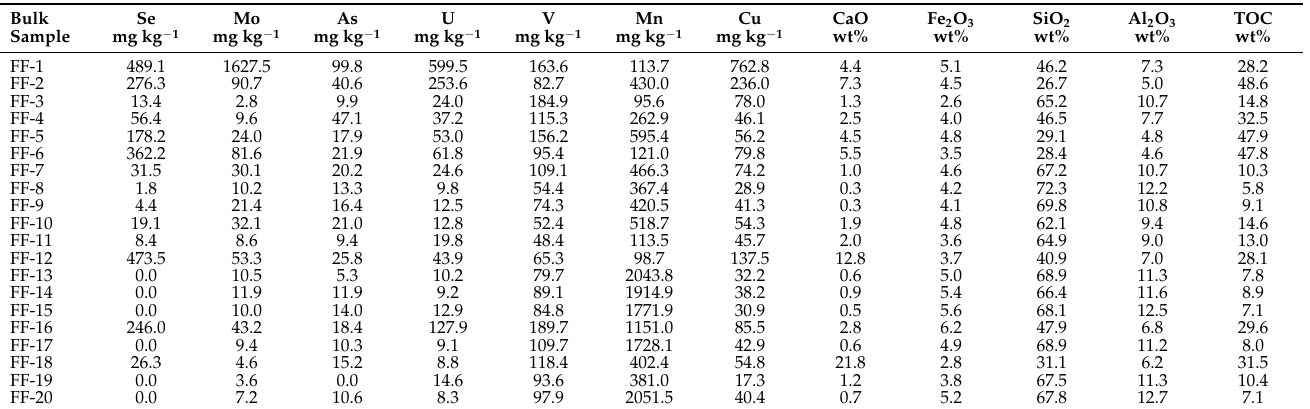
Table A2. X-ray fluorescence data showing the concentration of selected major and trace elements in soil samples collected at 10–20 cm depth at site FF TOC by loss on ignition.